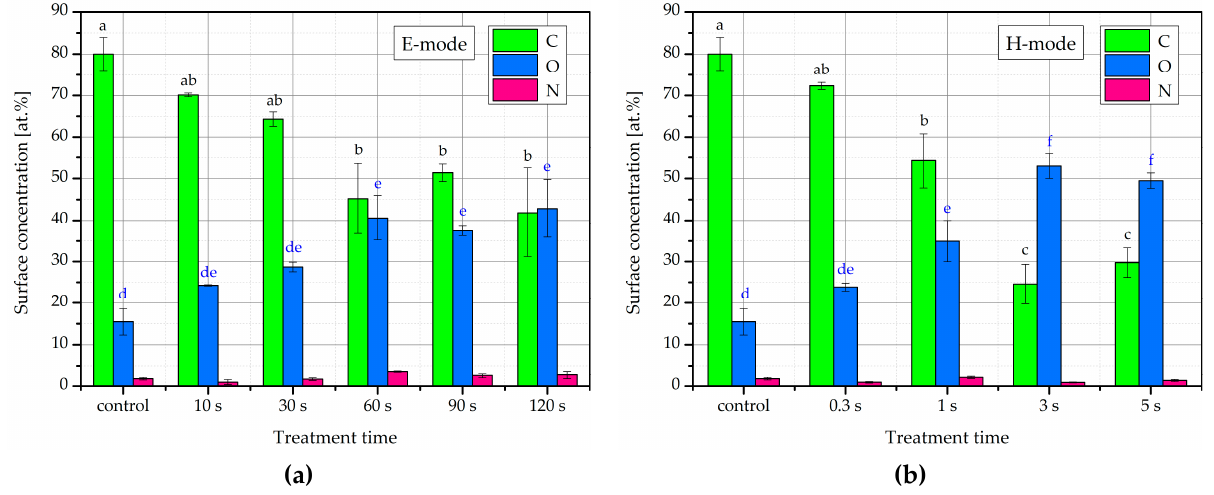
Figure 5. Alfalfa seed surface concentration of carbon, oxygen, and nitrogen, determined by X-ray photoelectron spectroscopy (XPS), after treatment with ( a )—E-mode or ( b )—H-mode plasma. The error bars represent standard error. Different lowercase letters above the bars represent statistically significant differences ( p < 0.05; post hoc Tukey’s range tests) between treatments for each individual element (C or O).